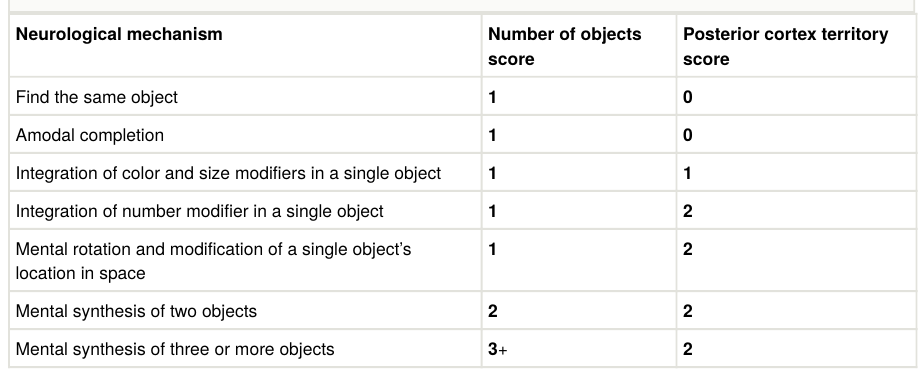
Table 1. The hierarchical classi fi cation of IQ test question by the NOB score and the PCT